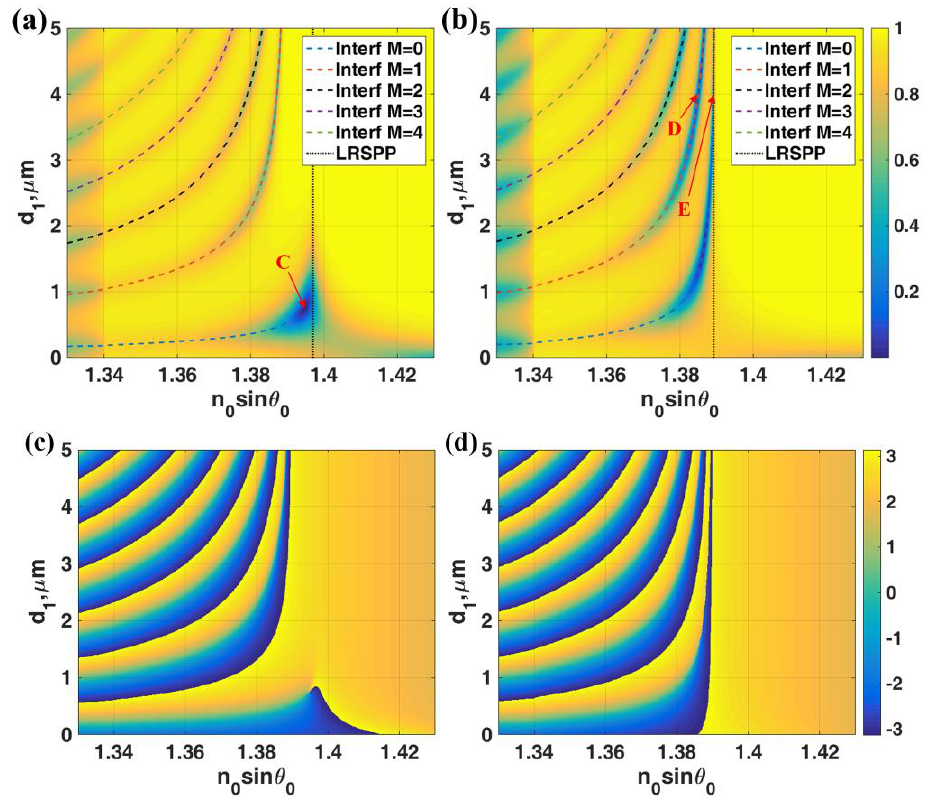
Figure 5. Simulation results for λ = 633 nm, n 0 = 1.52, n 1 = 1.39 with thickness d 1 and n 2 = 0.18344 + 3.4332 i with thickness d 2 and n 3 = 1.34. ( a ) |r p | 2 when d 2 = 30 nm and ( b ) |r p | 2 when d 2 = 20 nm ( c ) Phase(r p ) in rad when d 2 = 30 nm and ( d ) Phase(r p ) in rad when d 2 = 20 nm. The colored curves shown